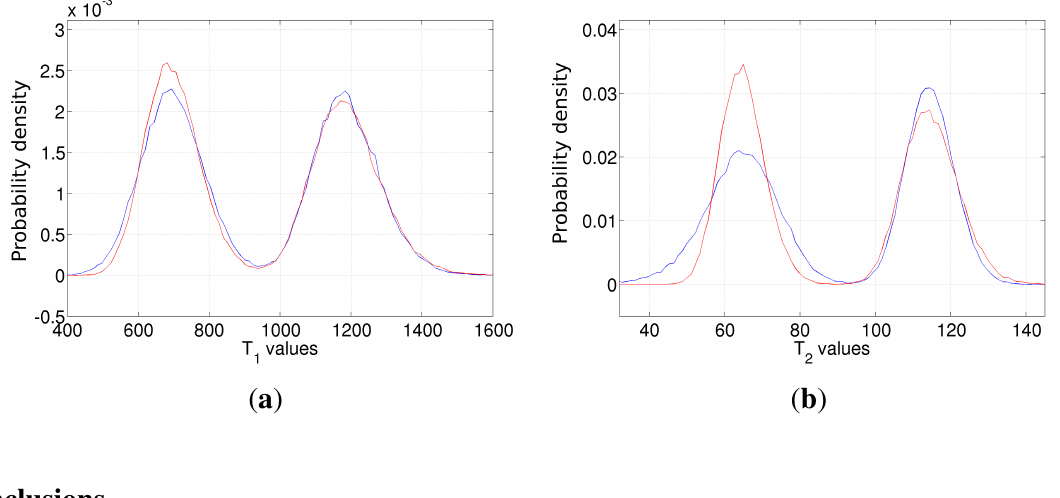
Figure 10. The empirical probability density function of the T in the case of Dataset 1 (blue line) and Dataset 2 (red line). Dataset 1 (blue line) imaging parameters are ideal for tissues with lower T ideal for the tissue with higher relaxation